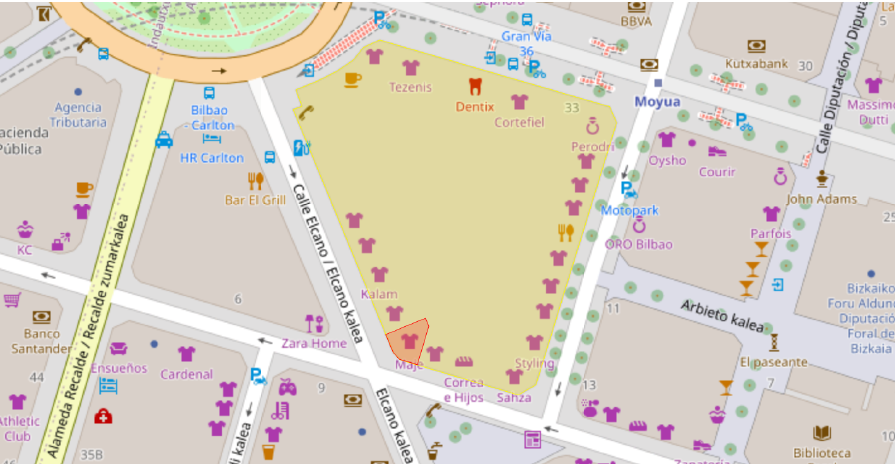
Figure 27. The final